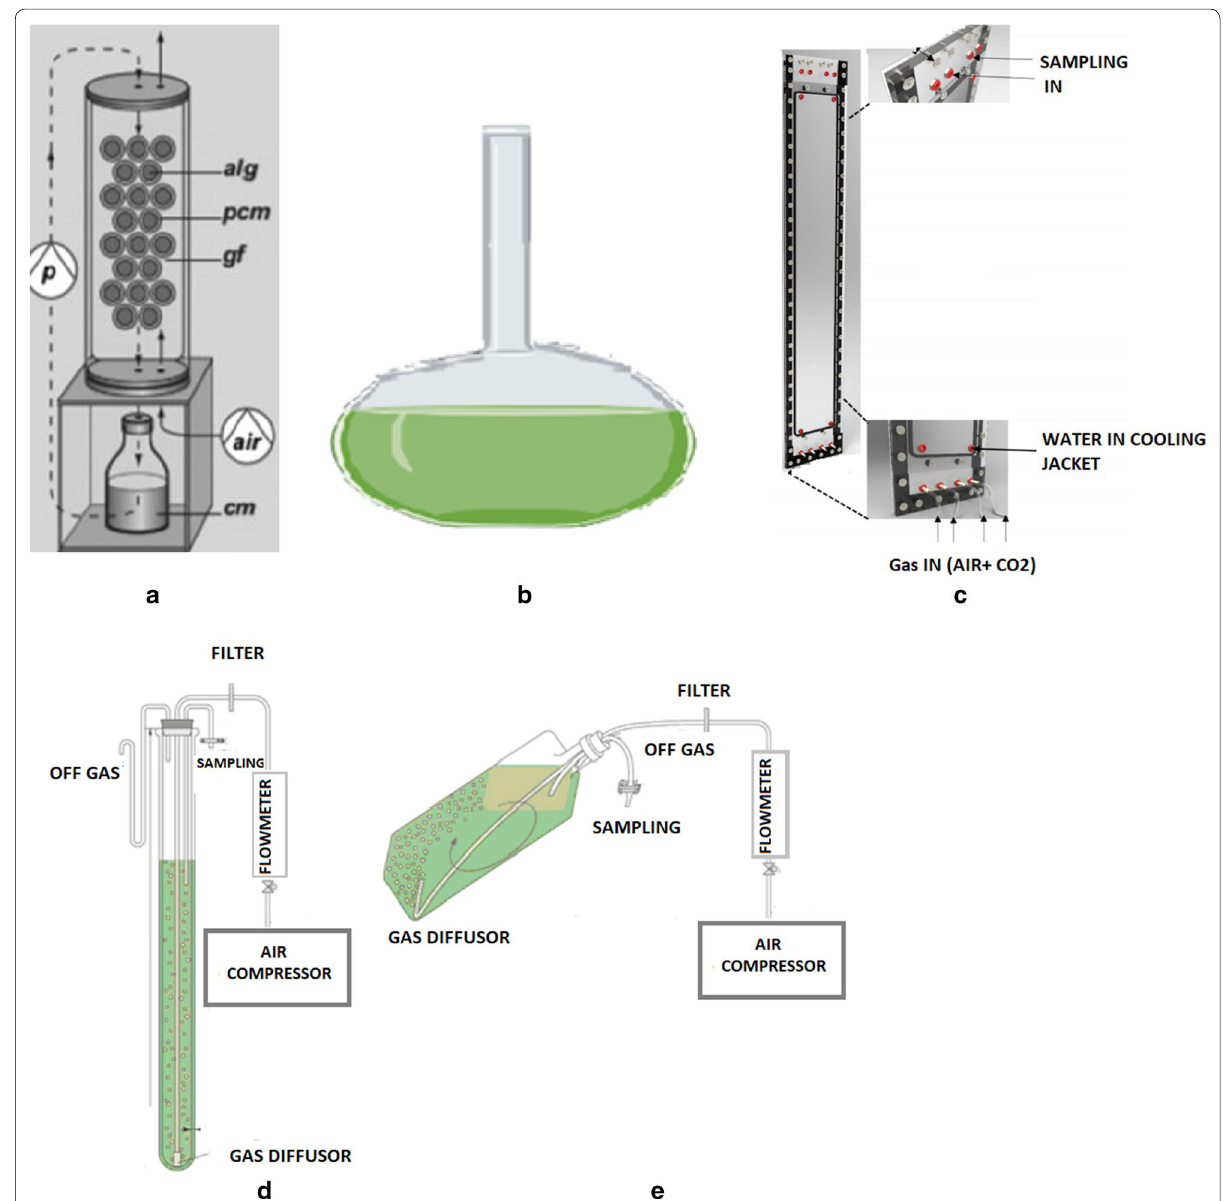
material, air membrane pump for air supply, cm culture medium (figure reproduced and modified from Carbone et al. 2017a, b); b Decanter (Decanter-LF); c A side view of Ultraflate photobioreactor (UP-B) (Gifuni et al. 2018 d Tubular bioreactor (Tubular-B); e Inclined bubble column (Inclined Bubble-C) (Olivieri et al.